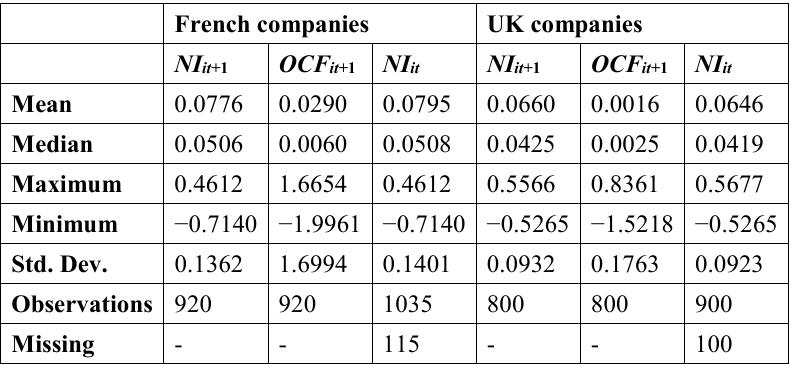
Table 1. Descriptive Statistics of